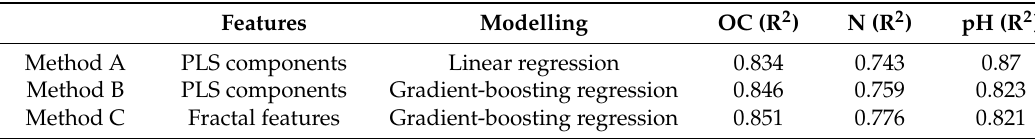
Table 3. Comparison of three methods for the quantitative retrieval of soil properties.